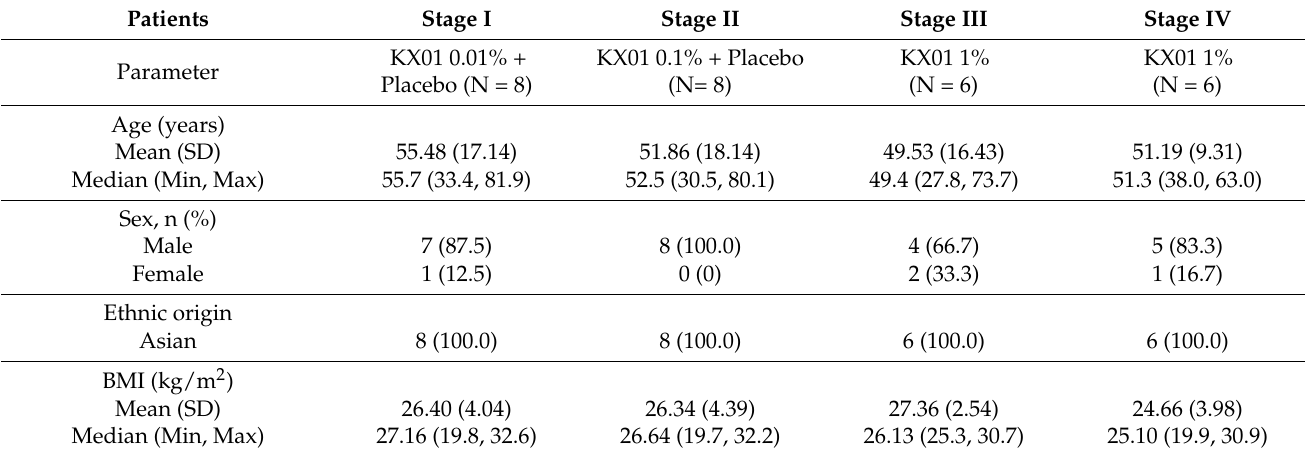
Table 1. Patient demographics and baseline characteristics (safety